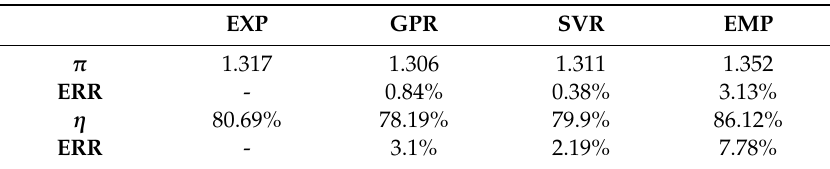
Table 6. Errors of total pressure ratio and adiabatic e ffi ciency.